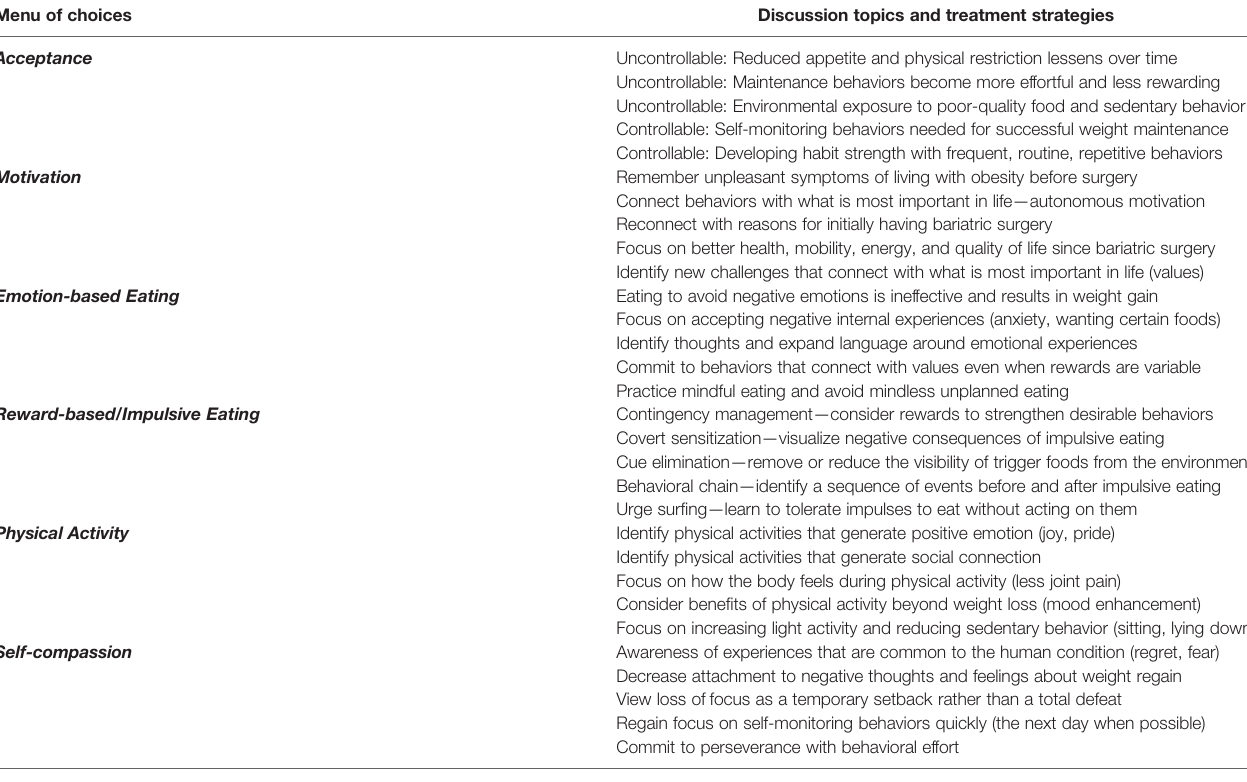
TABLE 1 | Menu of choices for discussion topics and treatment strategies for patients. Menu of